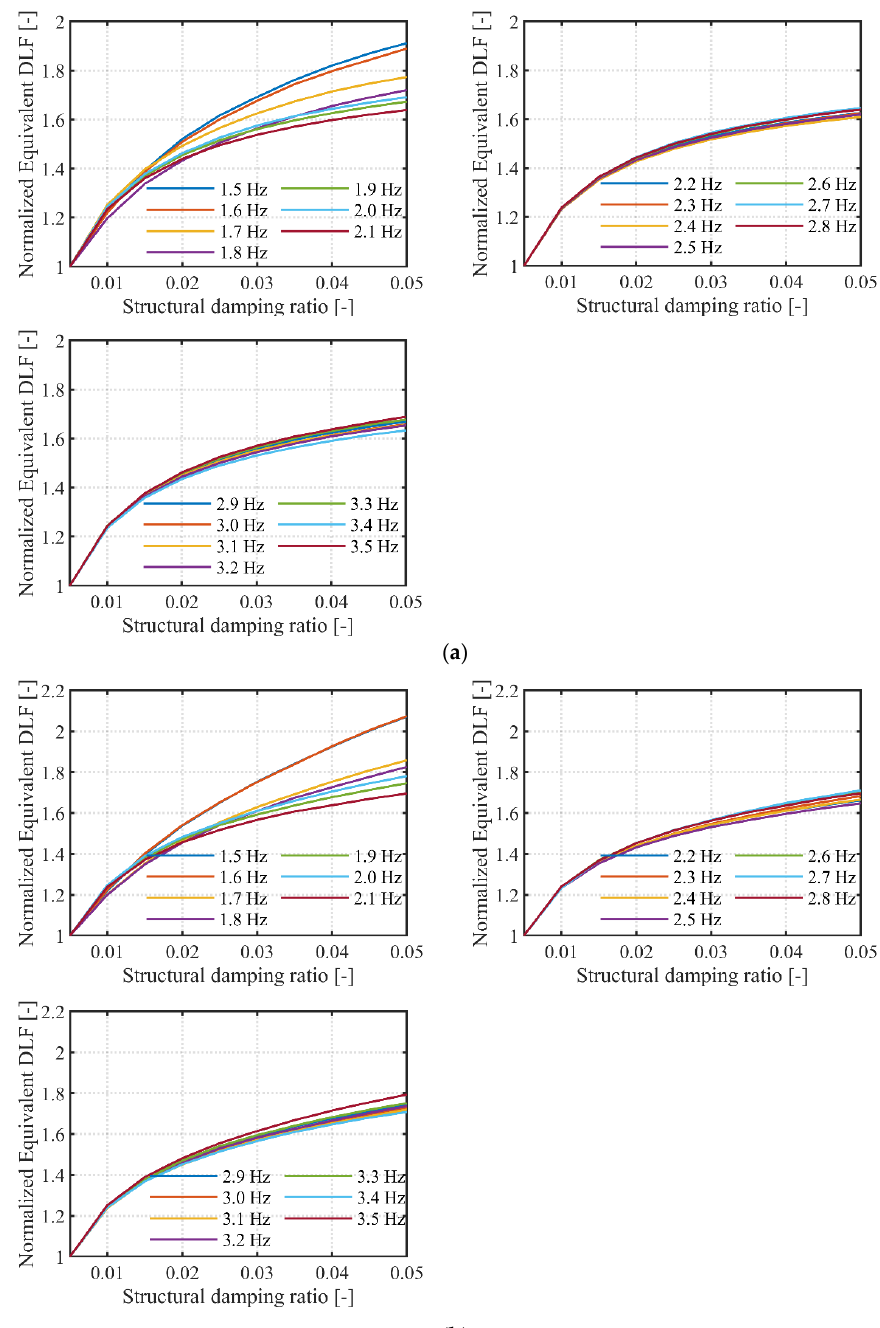
Figure 4. Relationship between structural damping ratio and normalized equivalent DLF. ( a ) Rela- tionship for the first harmonic, ( b ) Relationship for the second It is observed from Figure 4 that the influence of the structural damping ratio on the equivalent DLF is not greatly affected by the guidance frequency in general. Only at the low guidance frequency, such as 1.5 and 1.6 Hz, the influence is different and is slightly greater than the other guidance frequencies. Therefore, the influence of the guidance